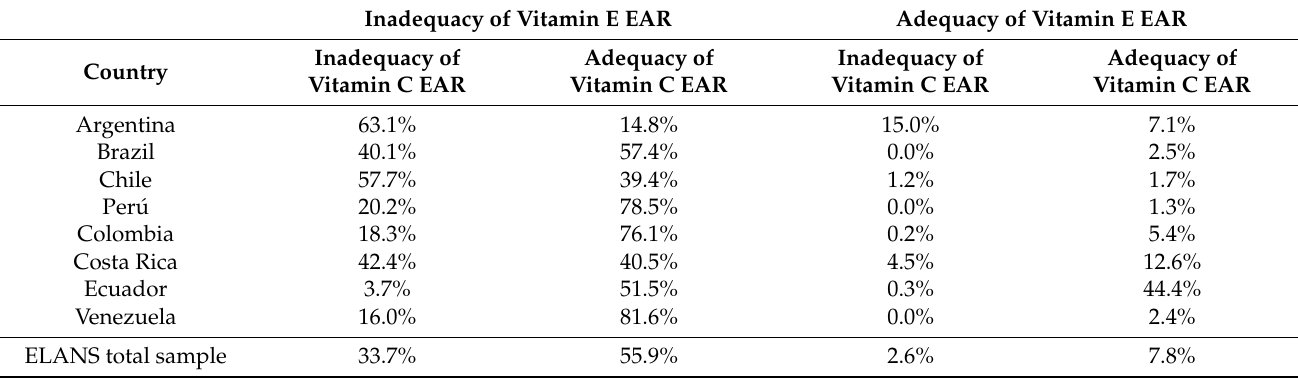
Table 4. Vitamin E and C combined adequacies and inadequacies in different countries from